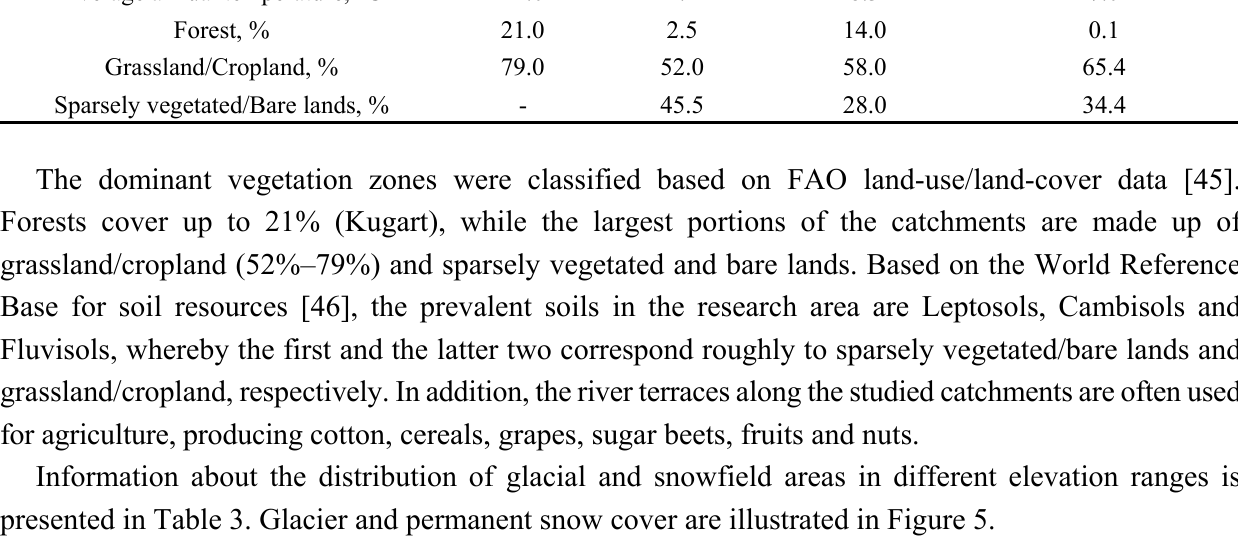
Table 3. Distribution of the glacier and permanent snow covered area at different elevations